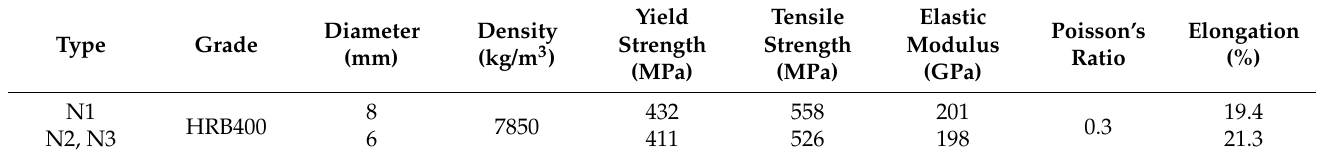
Table 7. Measured performances of steel